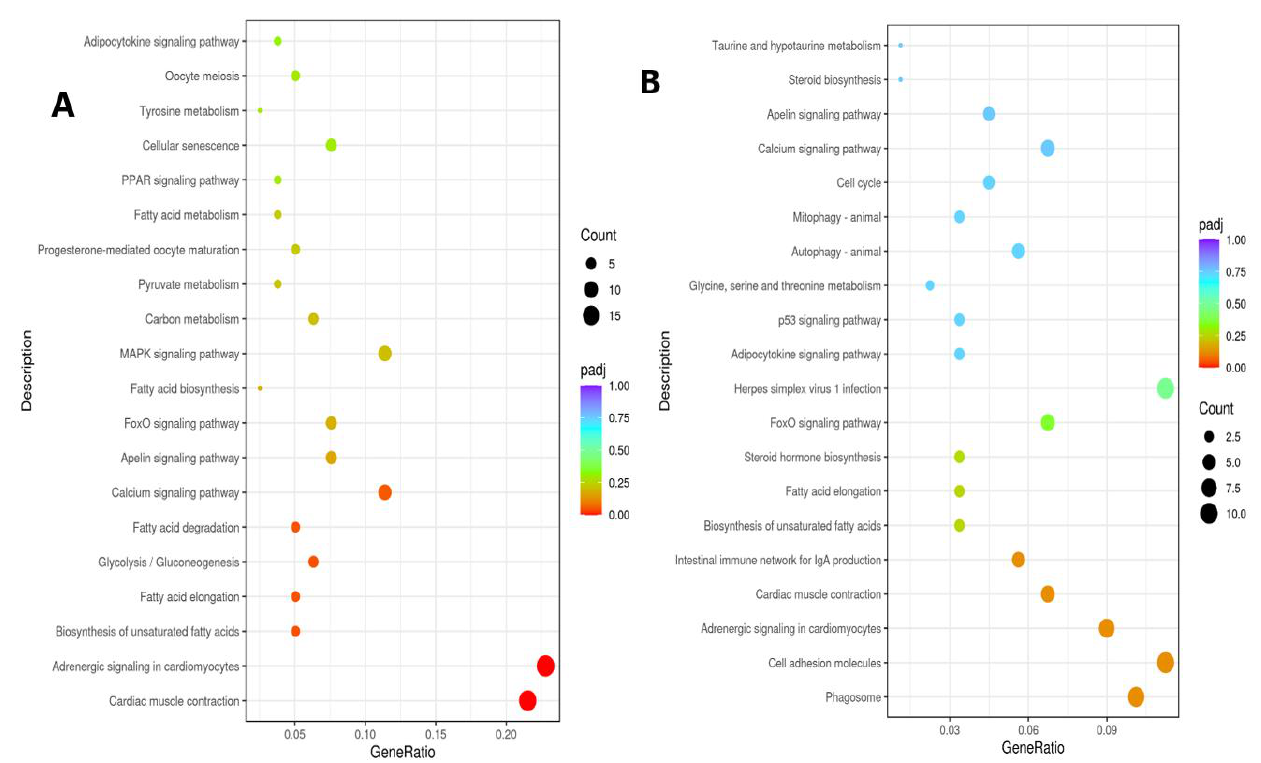
Figure 7. Dot plots representing the results of KEGG analysis showing the most significantly up- and down-regulated pathways under chronic stress. ( A ) KEGG analysis for the ammonia experiment showing the most significantly up- and down-regulated pathways. ( B ) KEGG analysis for the crowding experiment showing the most significantly up- and down-regulated pathways.